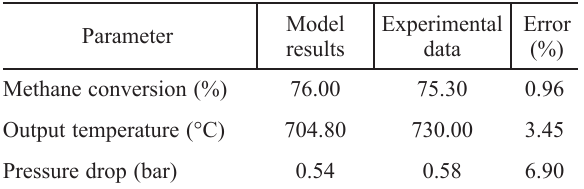
Table 4 – Comparison between model results and experi­ mental results Model Parameter